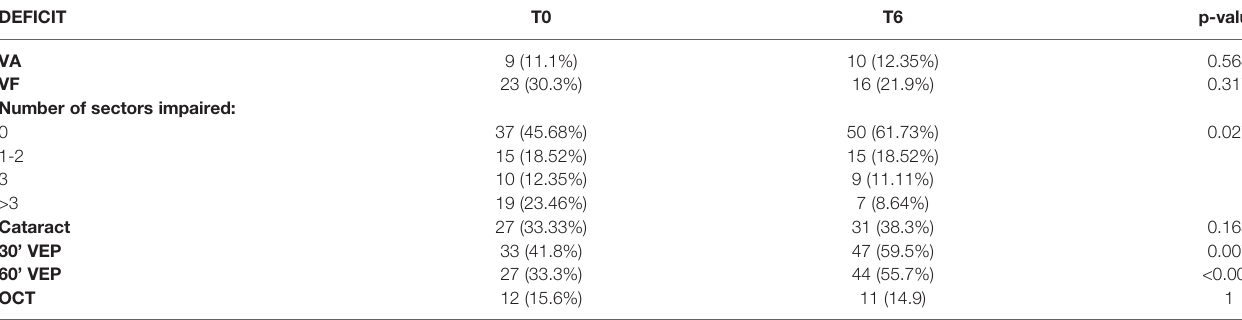
T0,numberofde fi citsatbaseline;T6,numberofde fi citsat6months;VA,visualacuity(abnormalifETDRS<55);VF,visual fi eld(pathologicalifaveragecorrectedde fi citdifferentby3points from general population); OCT, optical coherence tomography (abnormal if thickness < 60 micrometers); VEP, visual evoked potentials (abnormal if amplitude < 6 µV or latency >